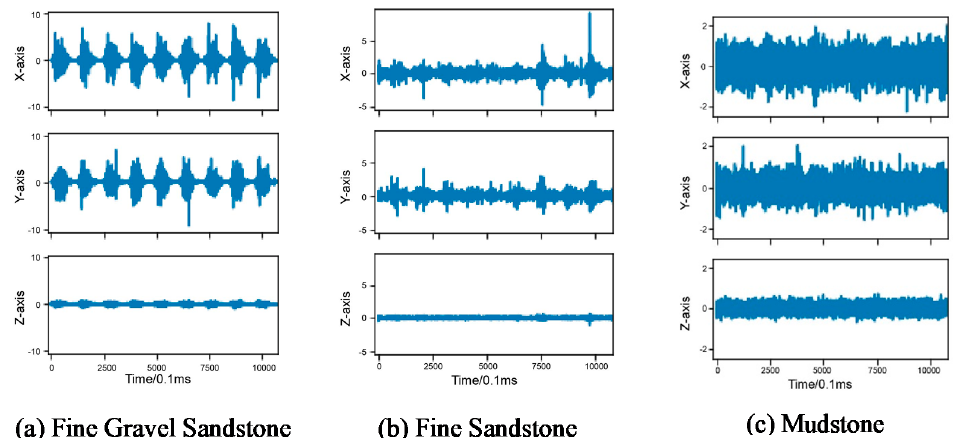
Figure 1. Typical time-domain diagram of three different lithologies.